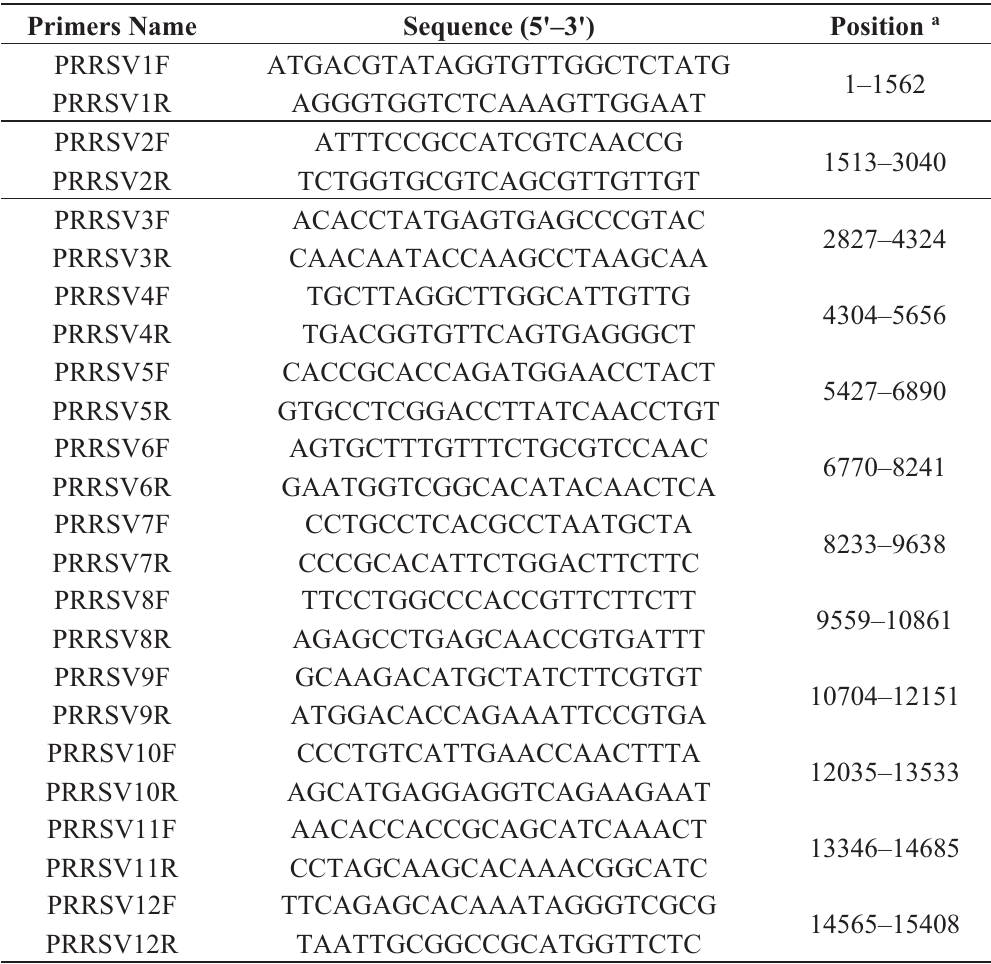
Table 1. Primers used for PCR for